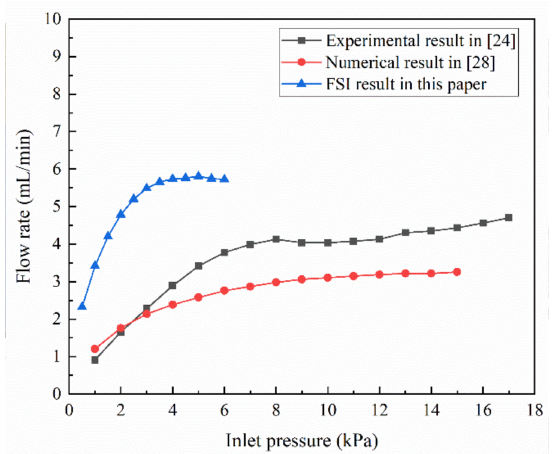
Figure 5. Comparison of experimental results with numerical results varied inlet pressure.